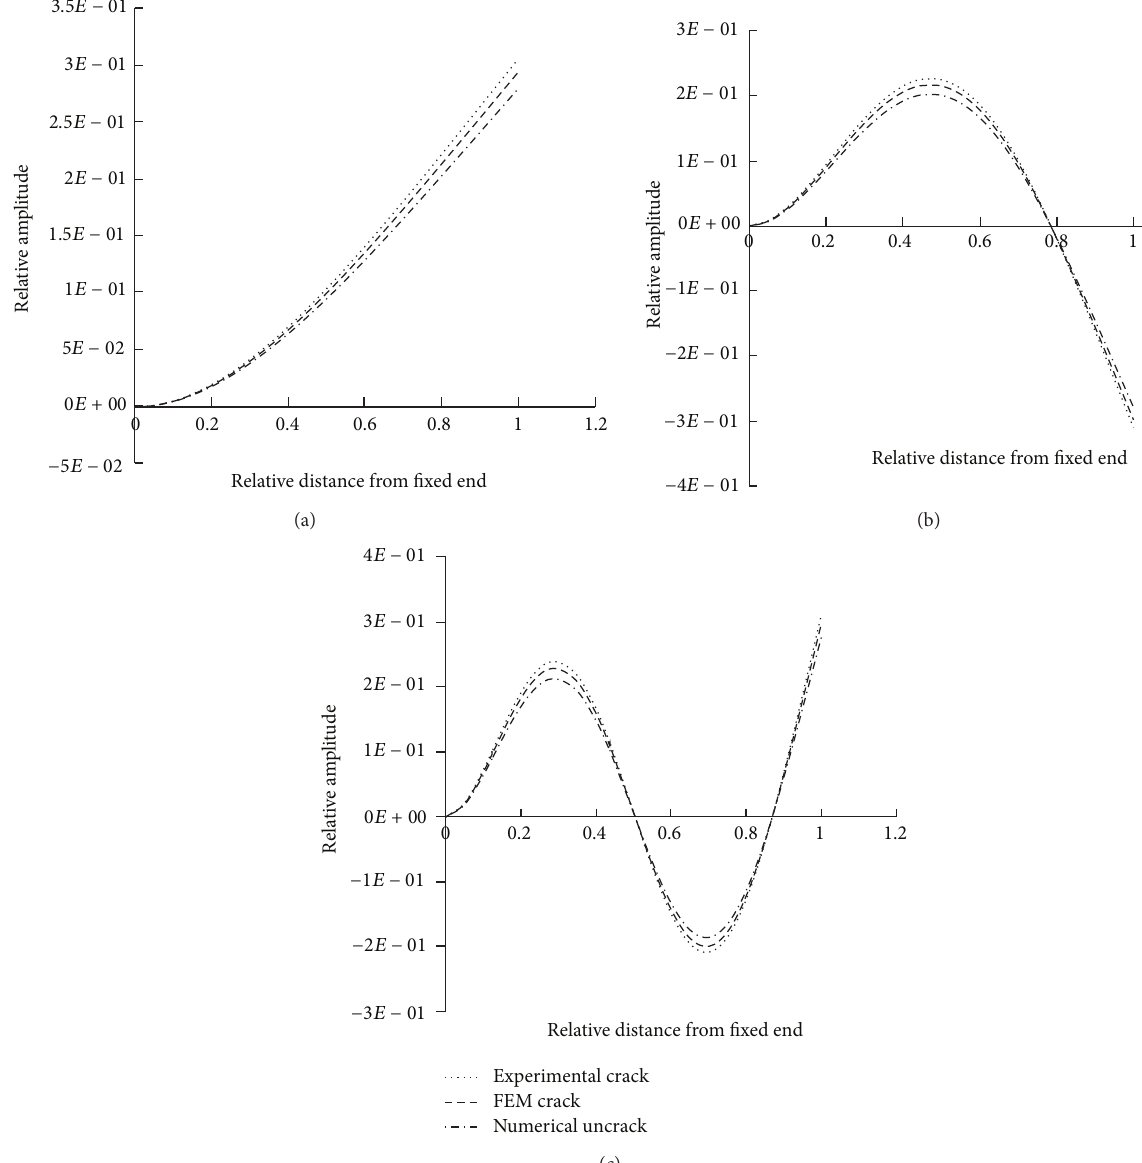
Figure 10: (a) Relative amplitude versus relative distance from the fixed end (1st mode of vibration), 𝑎 1 /𝑊 = 0.0833 , 𝑎 2 /𝑊 = 0.166 , 𝐿 1 /𝐿 = /𝐿 = 0.4375 . (b) Relative amplitude versus relative distance from the fixed end (2nd mode of vibration), 𝑎 0.125 , 𝐿 2 /𝐿 = 0.125 , 𝐿 /𝐿 = 0.4375 .(c)Relativeamplitudeversusrelativedistancefromthefixedend(3rdmodeofvibration), 𝑎 0.166 , 𝐿 1 2 /𝑊 = 0.166 , 𝐿 /𝐿 = 0.125 , 𝐿 /𝐿 = 0.4375 𝑎 2 1 2